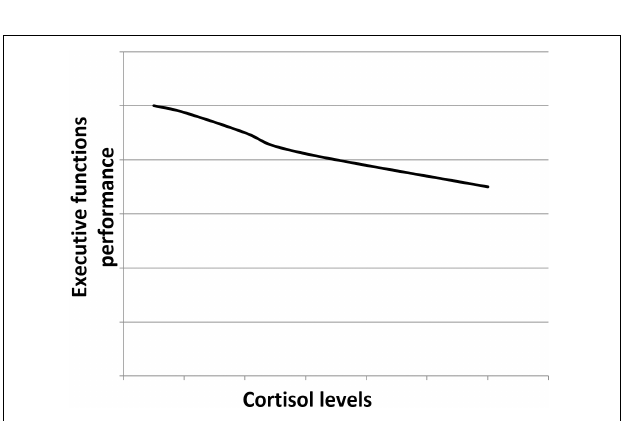
FIGURE 2 | Hypothetical dose–response relationship between the executive functions performance and the cortisol levels. As the prefrontal cortex only expresses GRs, the higher the cortisol levels, the poorer the executive functions